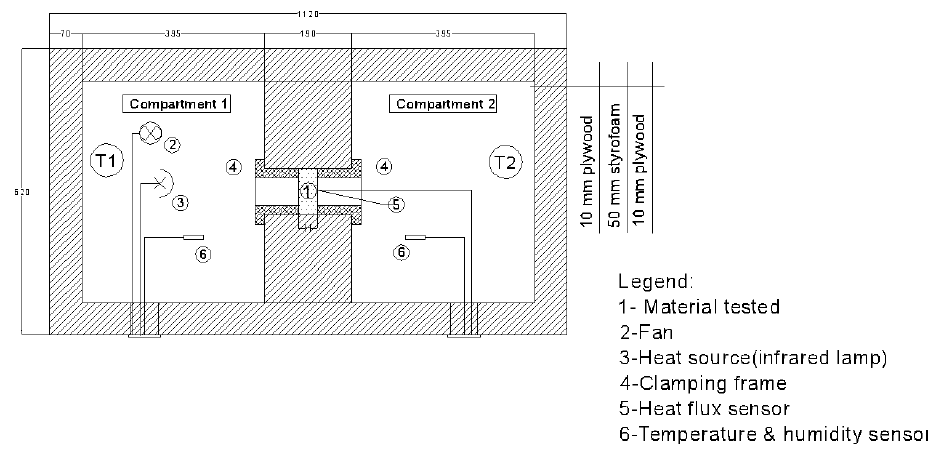
Figure 5. A diagram of a two-compartment heat